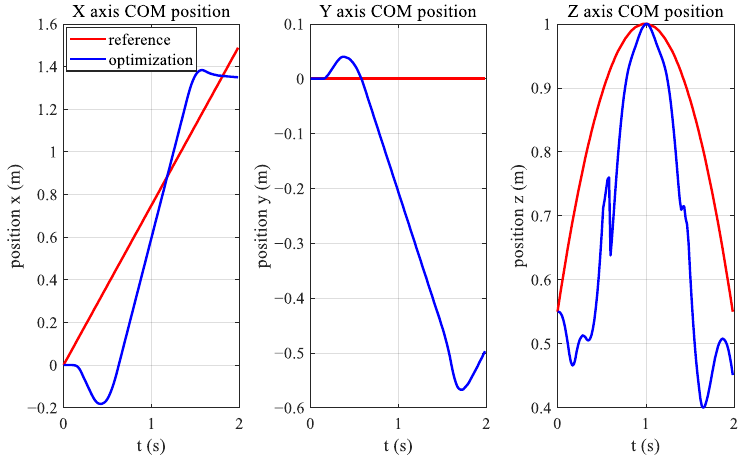
Figure 10. Position curve of the quadruped robot’s center of mass. The red curve is the value of the centroid reference position, and the blue curve is the centroid track after trajectory optimization.